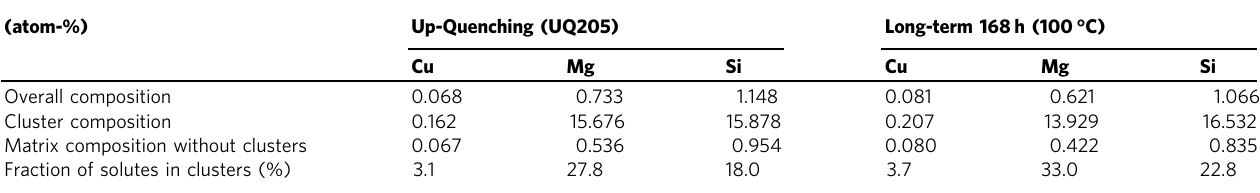
Table 1 Chemical analysis of the matrix and clusters found via APT.